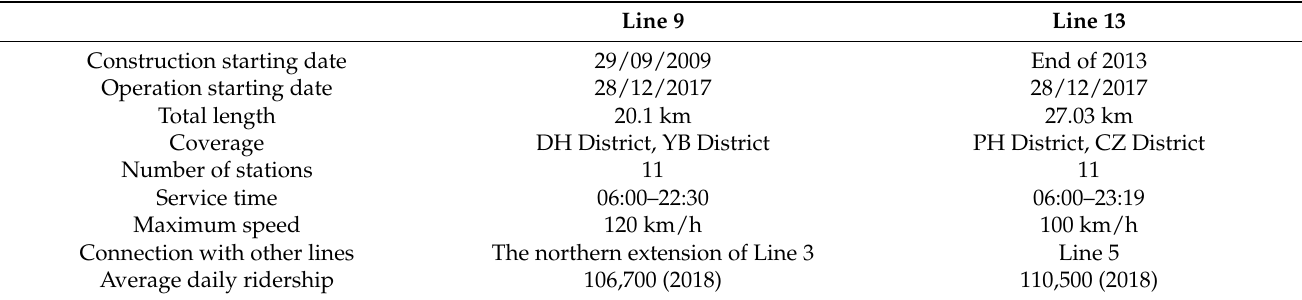
Table 1. A partial comparison of Line 9 and Line 13 (in